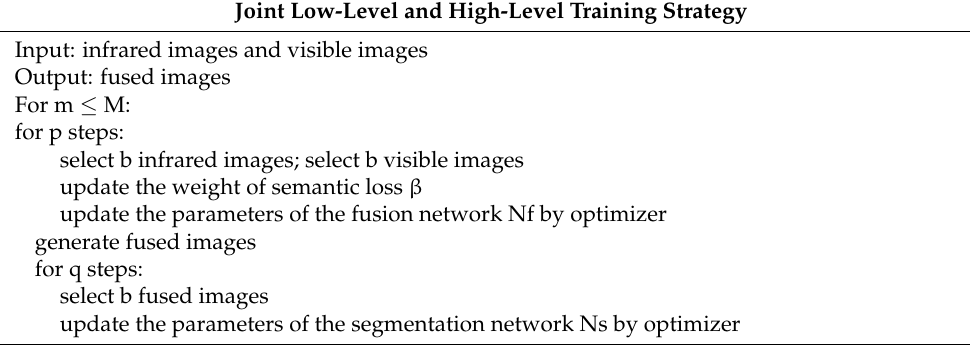
Table 1. The fusion augmentation training process. Joint Low-Level and High-Level Training